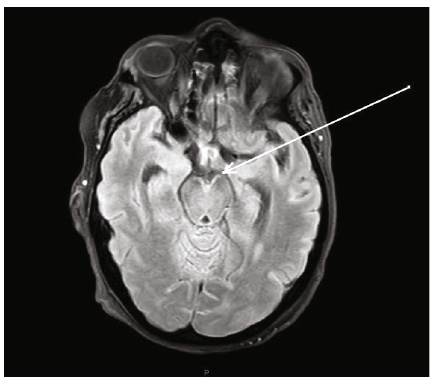
Figure 1: Brain MRI showing linear hyperintensities in basal segments and VIII, VII, V, and III cranial nerves (FLAIR sequence) (please see the arrow).